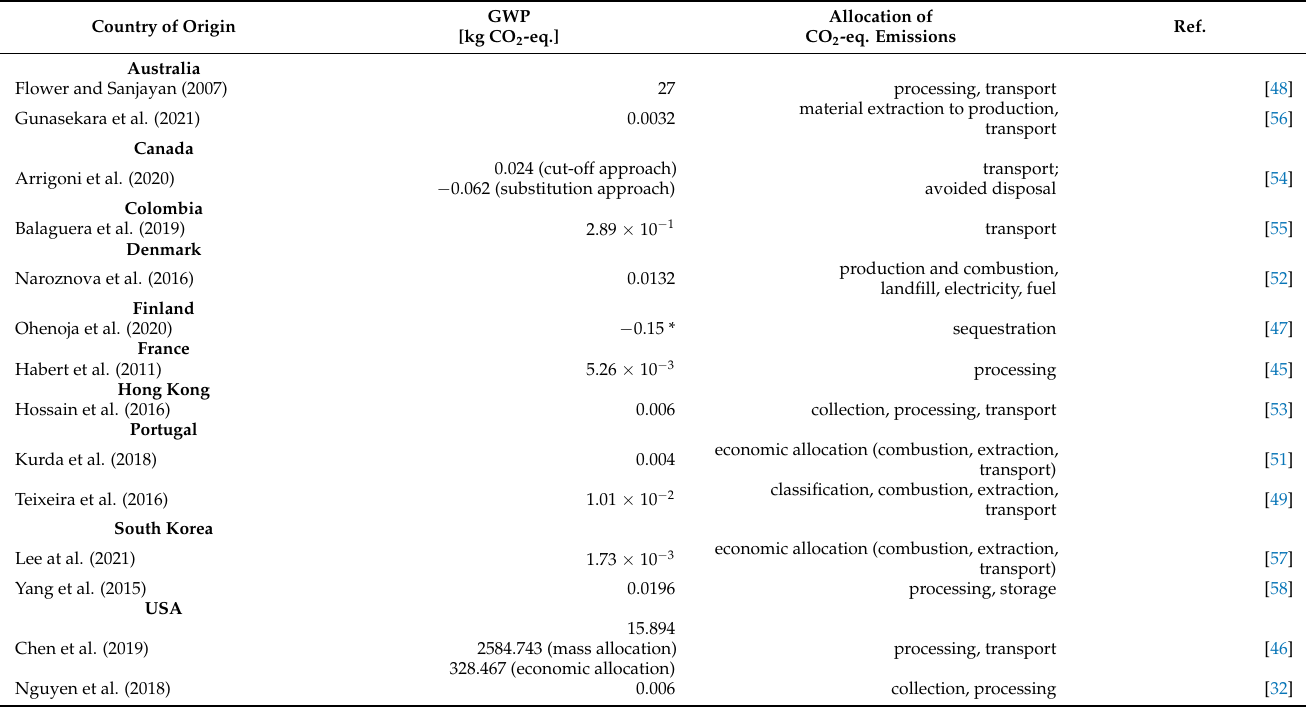
Table 2. GWP Data of Fly Ash Sorted by Country of